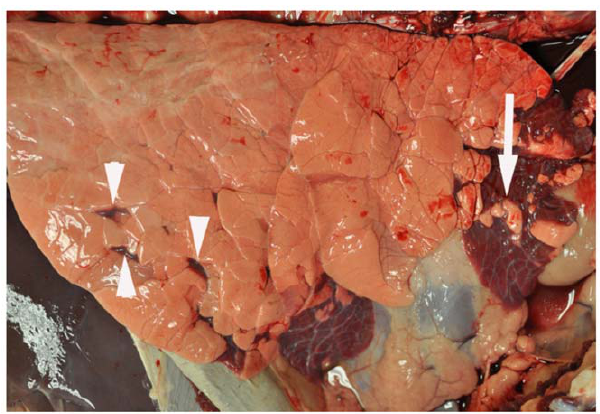
Figure 2. Right lung from an RSV-infected calf at day 7 post- infection. Note multifocal to coalescing areas of plum-red consolida- tion in cranial and ventral aspects of right cranial and middle lobes. Consolidated areas surround and divide foci of pale pink hyperinflated lung (arrow). Scattered multifocal areas of consolidation are also present in the ventral third of the right caudal lobe (arrowheads).